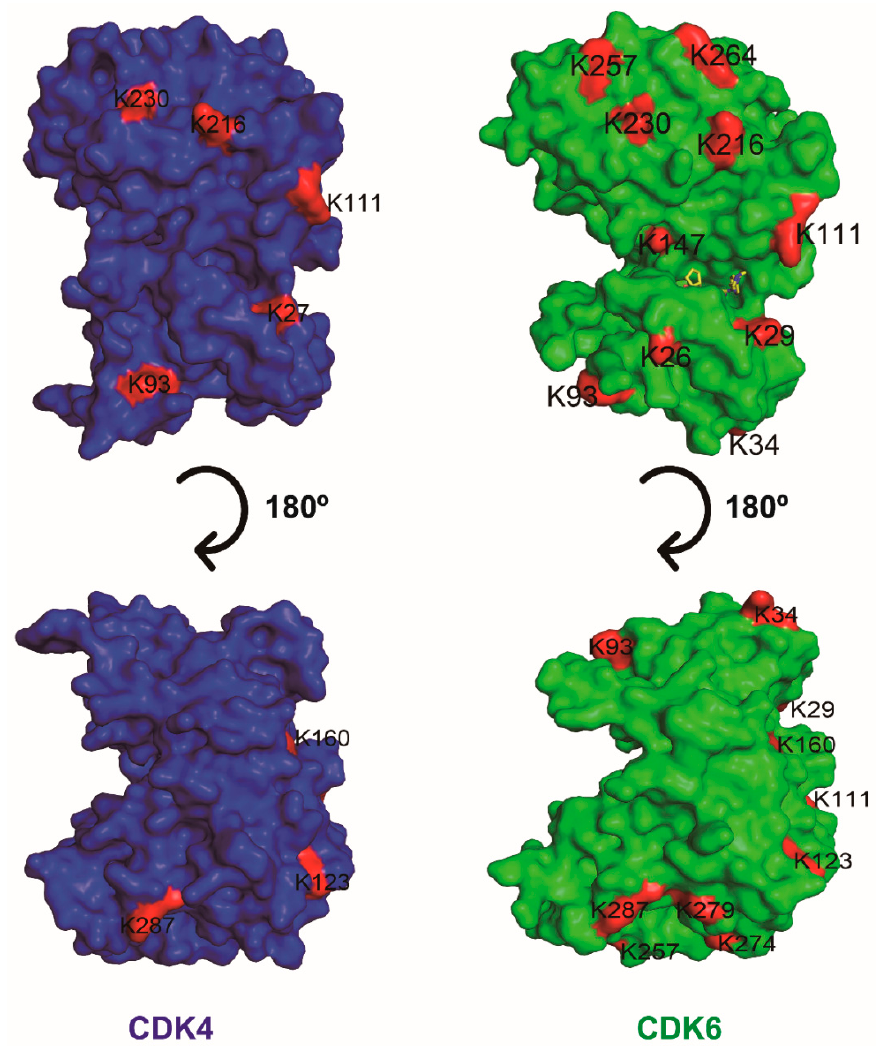
Figure 7. Surface drawing of the human CDK4 (blue) and CDK6 (green) structures in two different orientations. Surface-exposed lysine residues are colored red and labeled.